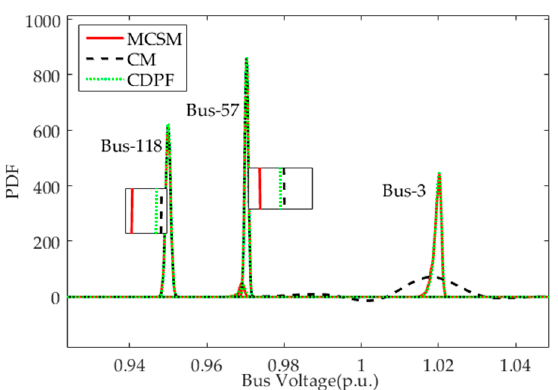
Figure 12. The PDFs of the voltage magnitude at bus-3, bus-57 and bus-118 in an IEEE 118-bus power system.